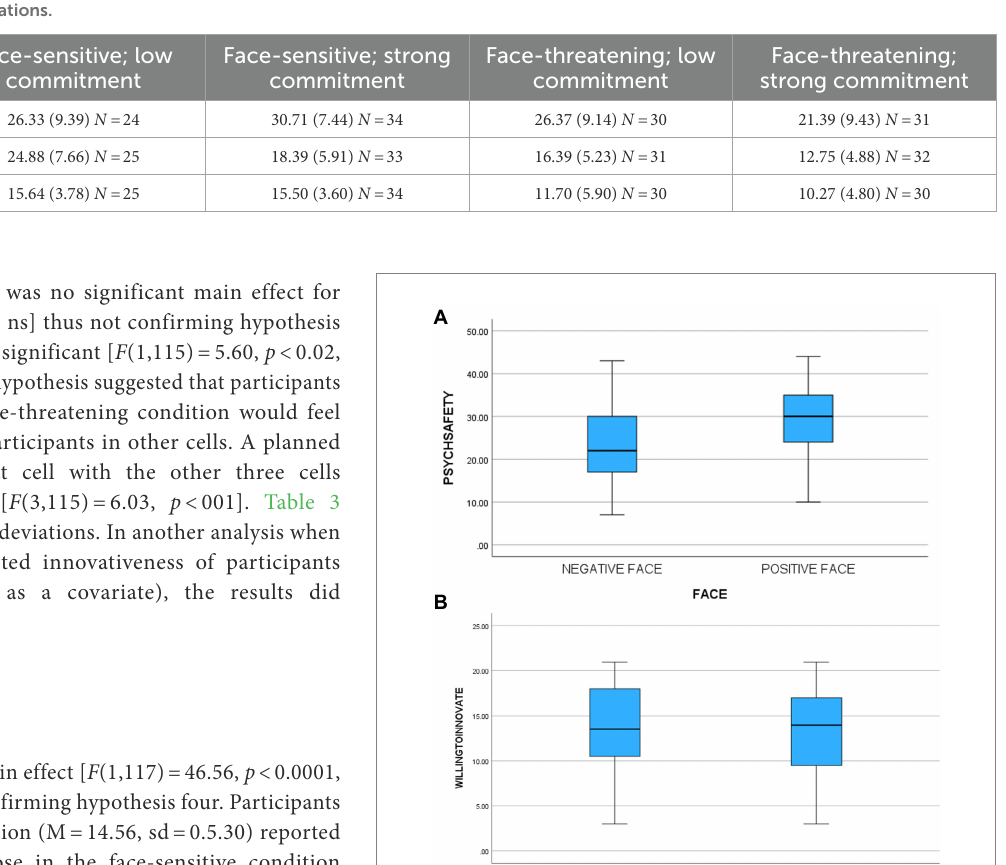
TABLE 3 Means and standard deviations.